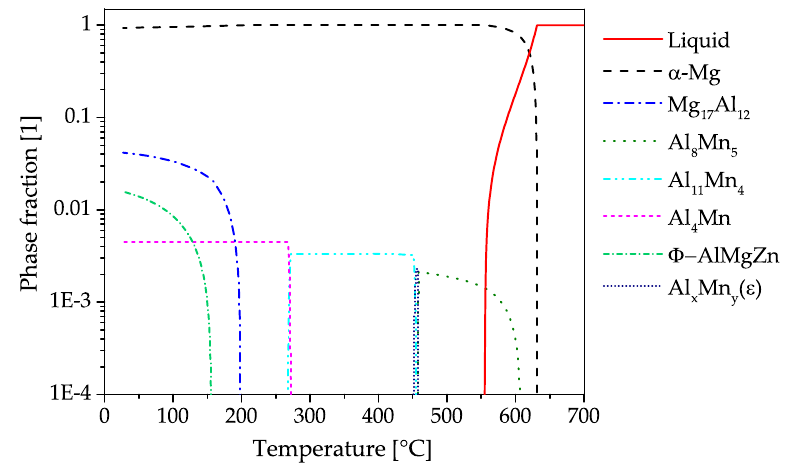
Figure 8. CALPHAD calculations (for further information see Appendix A) of AZ31 in a temperature range of 25 to 700 ◦ C, showing phase fractions of 10 − 4 to